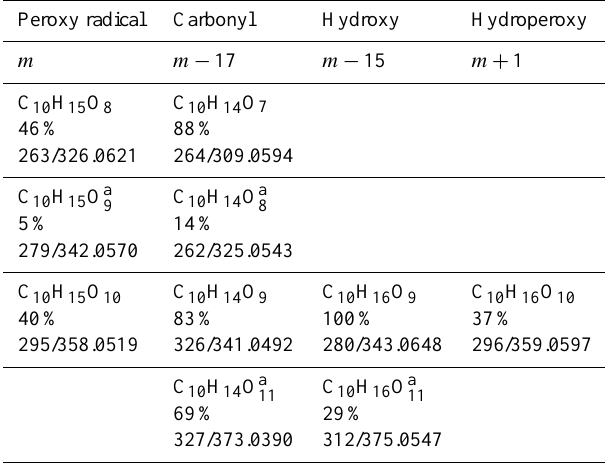
Table 12. HOM products observed during ozonolysis of α -pinene. The second header line shows at which molar masses the termina- tion products are expected relative to the peroxy radical with molar mass m (unit masses). Filled cells indicate that these compounds were detected with given elemental composition and relative inten- sity (second line in the same cell). Relative intensities were normal- ized to the largest HOM signal. The third line in the cell gives the molar mass [Da] in unit mass resolution and the precise m/z [Th] at which the molecule was detected as cluster with 15 NO − Peroxy radical Carbonyl Hydroxy Hydroperoxy m m − 17 m − 15 m + 1